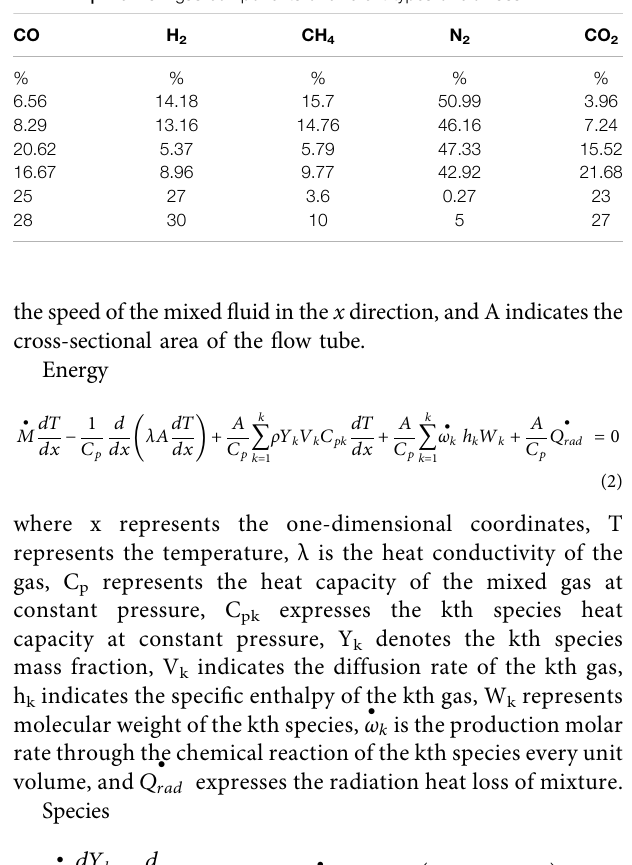
TABLE 1 | The main gas components of different types of biomass. TABLE 2 | Composition of typical low calori fi c value biogas.